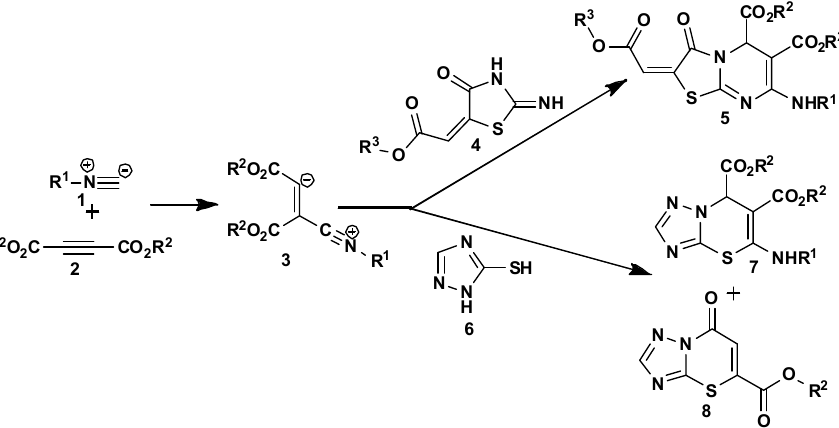
Scheme 1. Our previous work showing synthesis of pyrimidine derivatives and their